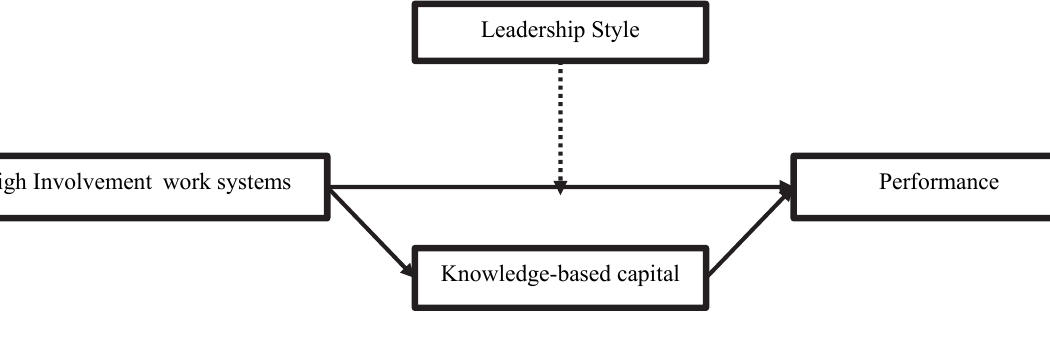
Fig. 1. Research theoretical